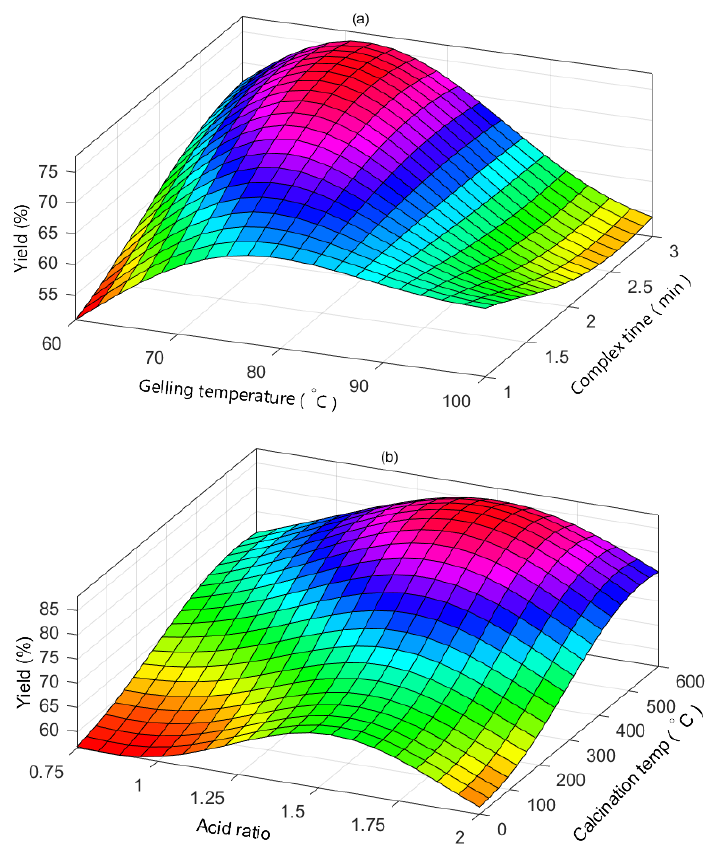
Figure 4. Three-dimensional plots of the effects of ( a ) gelling temperature and complex time, ( b ) cal- cination temperature and acid ratio interactions on the catalytic activity of the catalyst in the esterifi- cation reaction